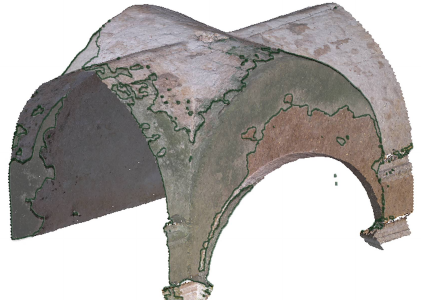
Figure 8 . Case 1: superimposition of cluster 1 (biological colonization) to the original point cloud to the original point